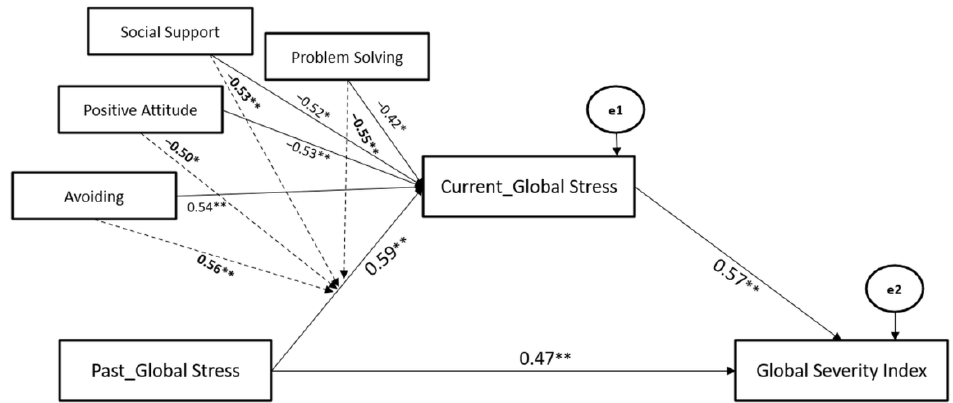
Figure 2. The Mediated ‐ Moderated model of Past and Current Global Stress, Coping Strategies, and Global Severity Index. Moderating effects values are reported in bold along the dotted arrows. ** p < 0.01; * p < 0.05.